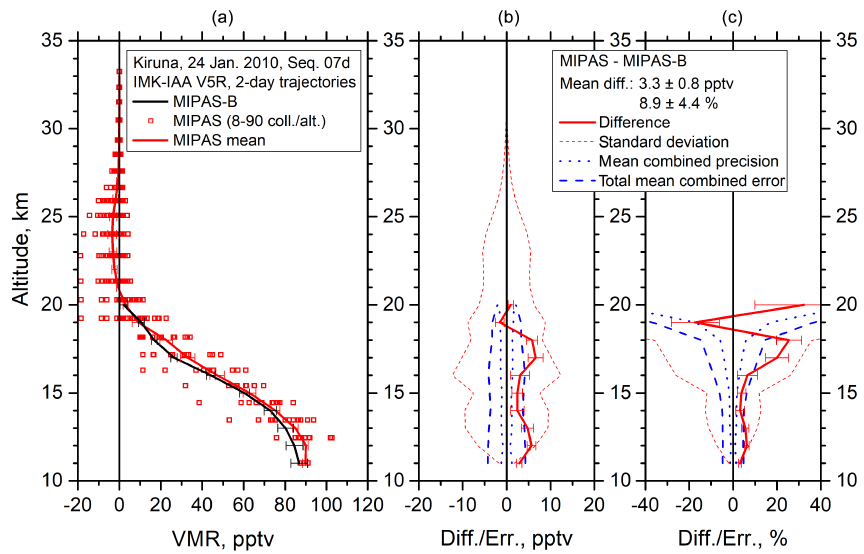
Figure 14. Comparison of MIPAS Envisat and MIPAS-B2 CCl 4 for the MIPAS-B2 flight on 24 January 2010 over Kiruna, Sweden. (a) Mean profile of all coincident profiles (black line: MIPAS-B2; red line: MIPAS mean; red squares: coincident MIPAS measurements). (b) Absolute total error budget without consideration of the spectroscopy error. (c) Relative error budget − red continuous line: difference between the mean profiles; red dotted line: standard deviation; blue dotted line: mean combined precision; blue dashed line: total mean combined